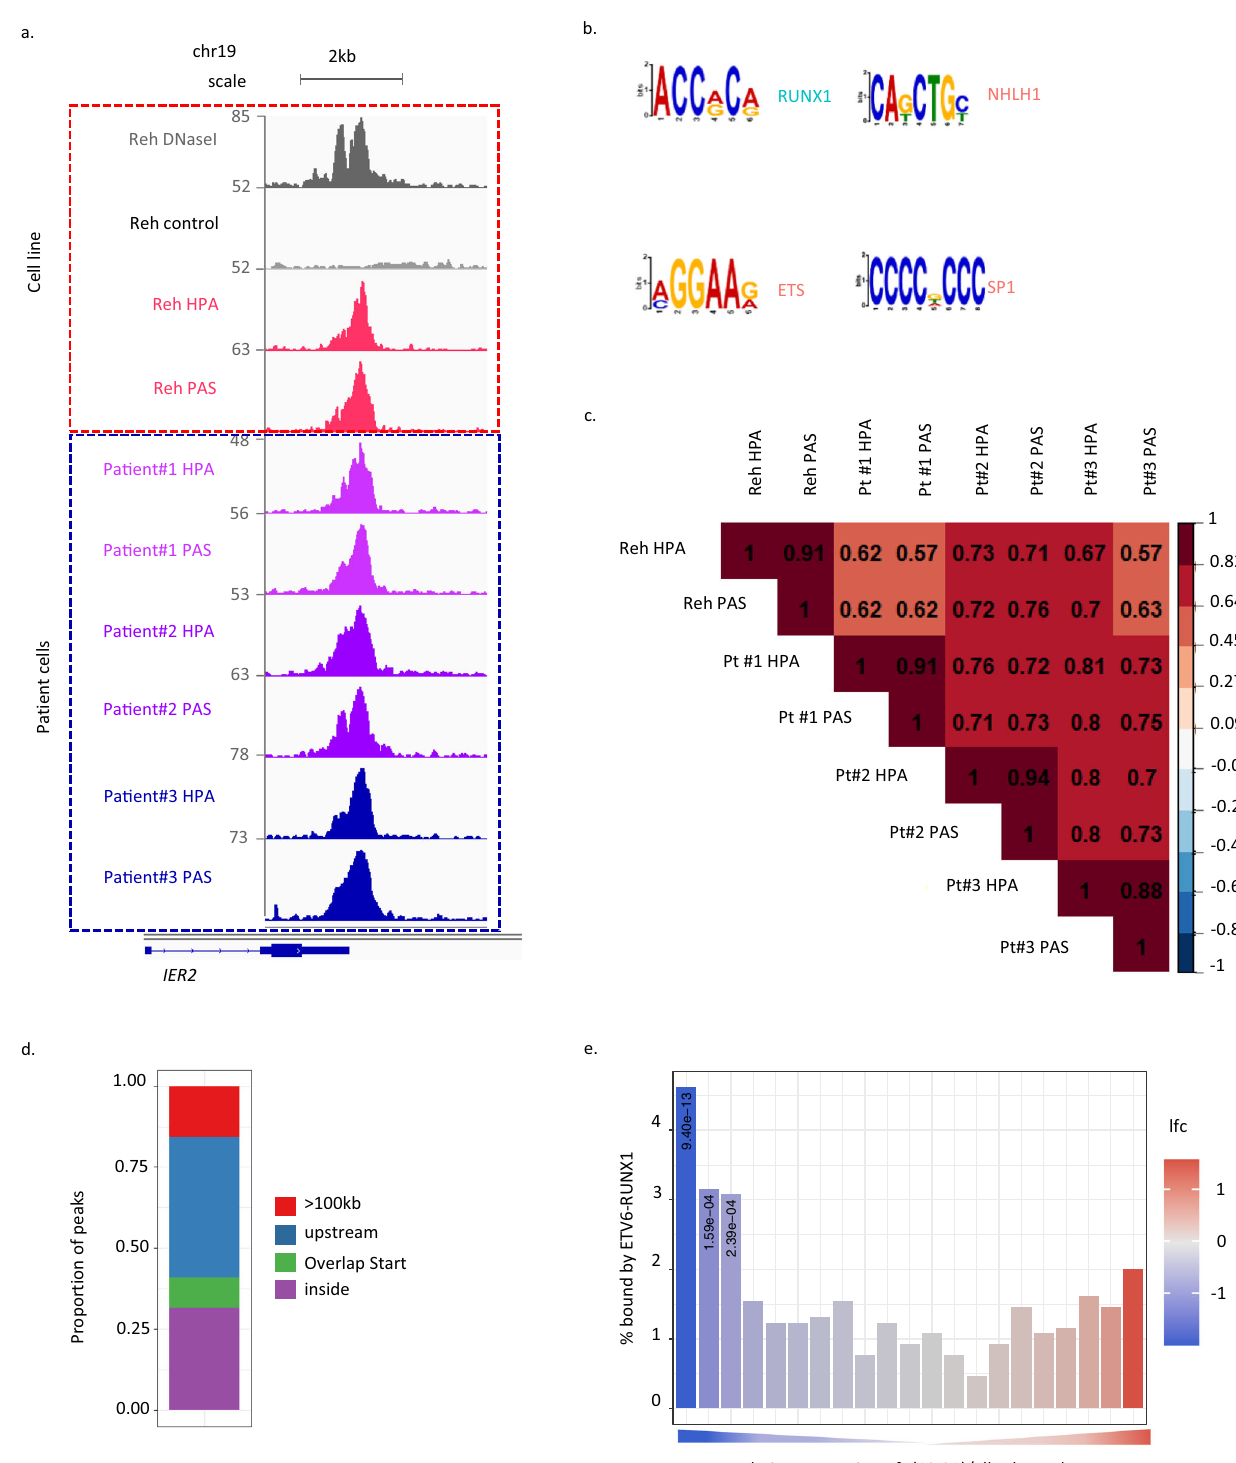
rela(cid:2)ve expression of t(12;21)/all other subtypes signalacross all ETV6-RUNX1 binding sites. d Distributionofpeaks relative to their nearest genes (see methods for analysis). e ETV6-RUNX1 binding across genes binned according to relative expression in ETV6-RUNX1+ B-ALL as compared to all other subtypes. lfc: log2 Fold Change. One-way Fisher ’ s exact test revealed sig- ni fi cant overrepresentation of ETV6-RUNX1-bound genes in the indicated groups, Benjamini & Hochberg correction for multiple testing applied, only adjusted p values<0.05 are shown ( e ). Source data are provided as a Source Data fi